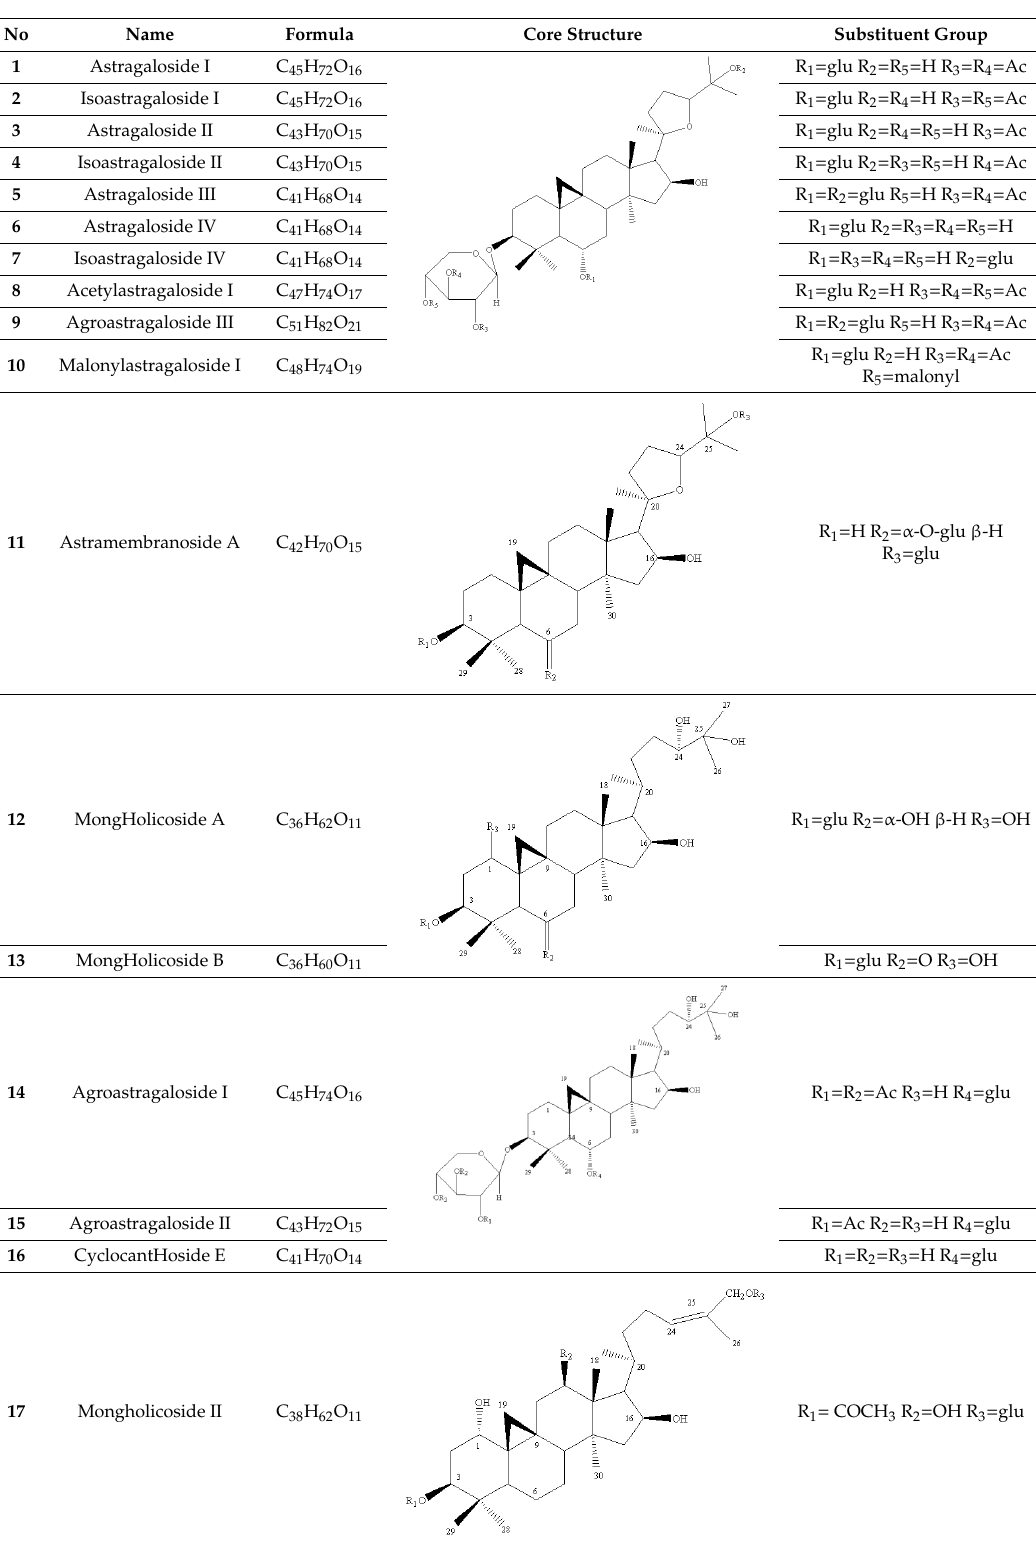
Table 3. Chemical information of identified saponins in AR and FAR.